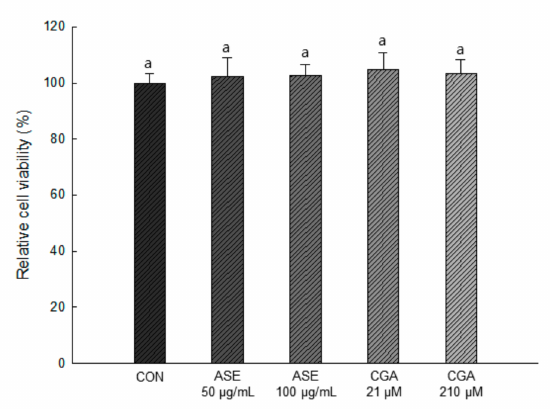
Figure 4. E ff ect of ASE and CGA on cell viability. After 6 days of MDI treatment, cell viability was measured by sodium 2,3,-bis(2-methoxy-4-nitro-5-sulfophenyl)-5-[(phenylamino)-carbonyl]- 2H-tetrazolium (XTT) and N-methyl dibenzopyrazine methyl sulfate (PMS) reagents and absorbance was measured at 734 nm. Each value is expressed as the mean ± SD of triple determination. The other letters on the bars indicate a significant di ff erence of p < 0.05 in the Duncan multi-range test. a significant di ff erences among various parts of